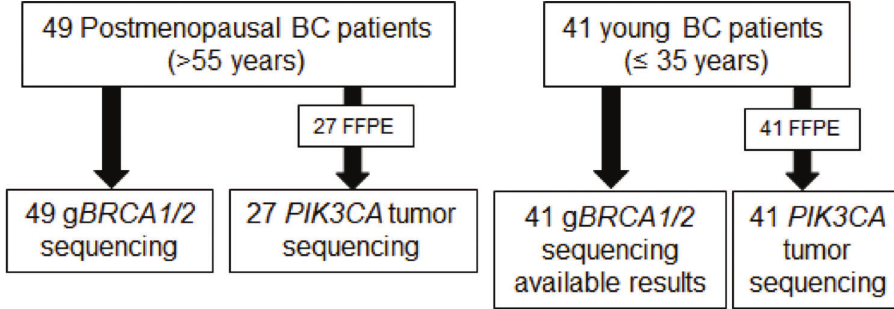
Figure 1 - The flowchart summarizes the samples used for each